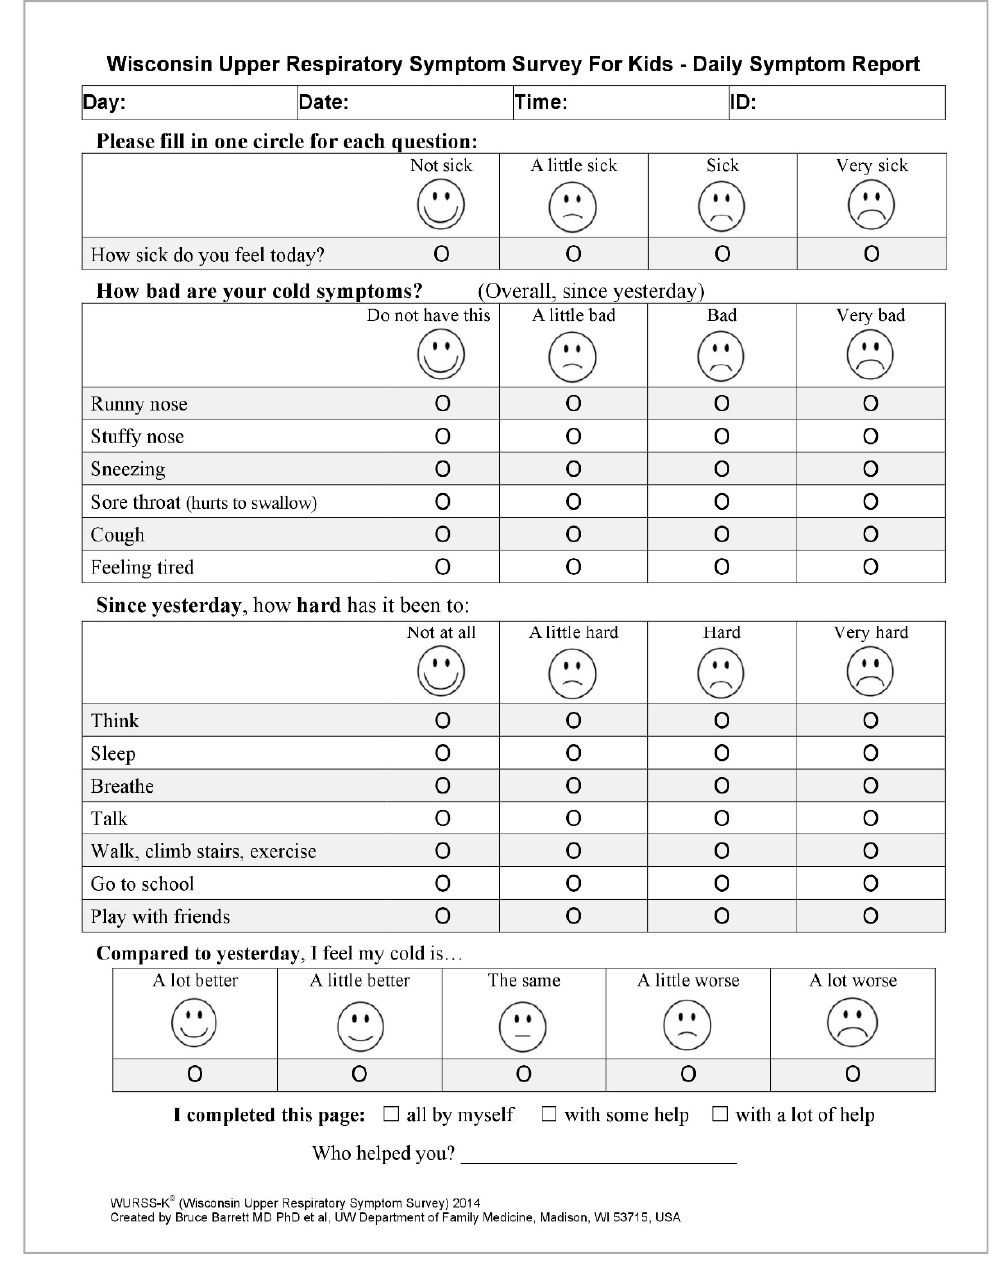
Figure 2. Wisconsin Upper Respiratory System Survey for Kids (WURSS-K)—questionnaire for daily assessment of the symptoms of URIs [35].